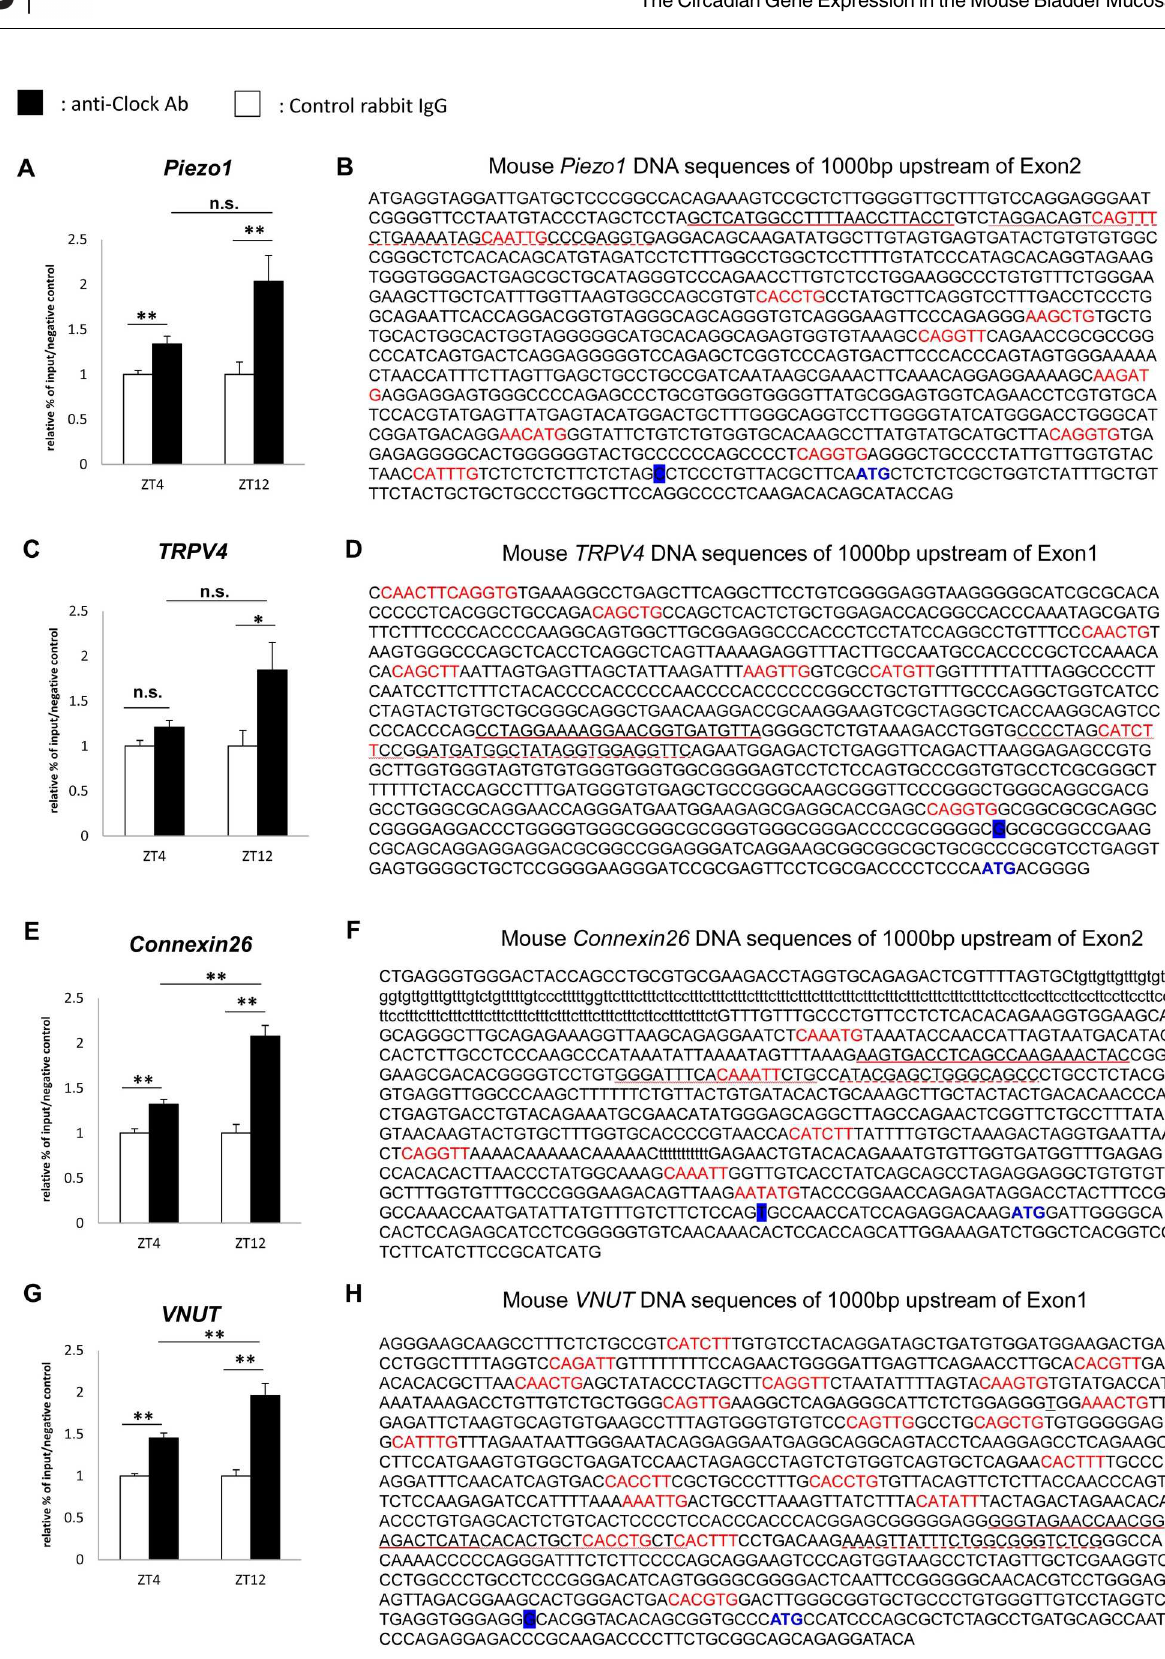
Fig 4. Detection of Clock binding to promoter regions. Clock bindingto the E-box site on their sequencesat ZT12 and ZT4, and these DNA sequencescontainingpromoterregions and severalnon-canonical E-box-like elements. (A) and (B) Piezo1 .(C) and